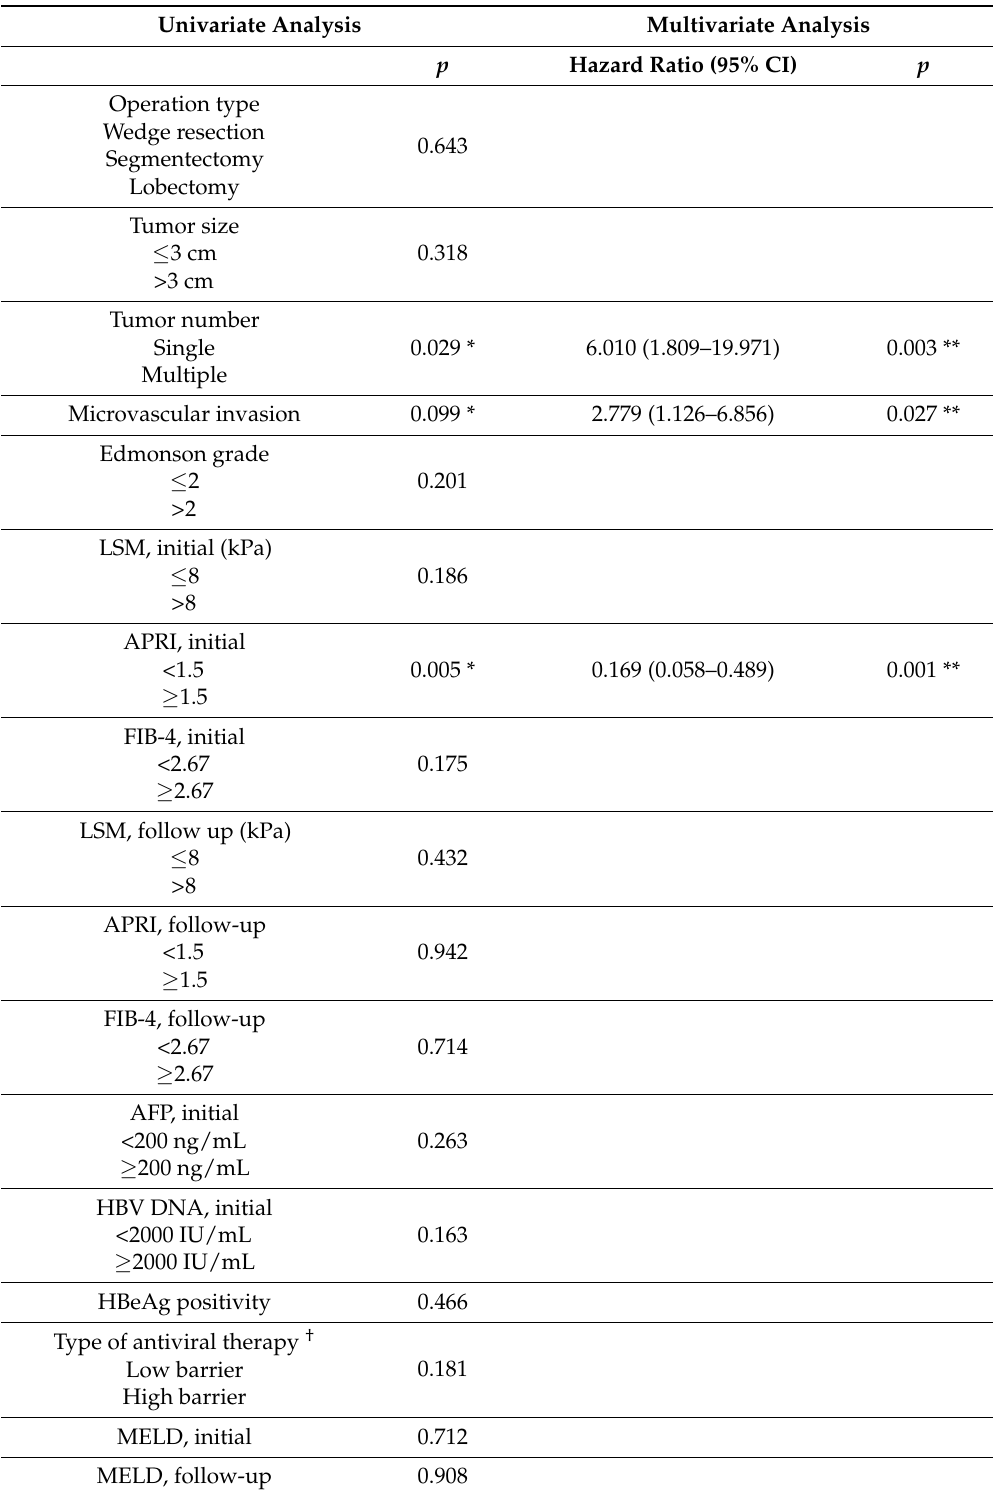
Table 5. Independent predictions of early recurrence after curative HCC resection in patients with pathologically confirmed liver cirrhosis under antiviral